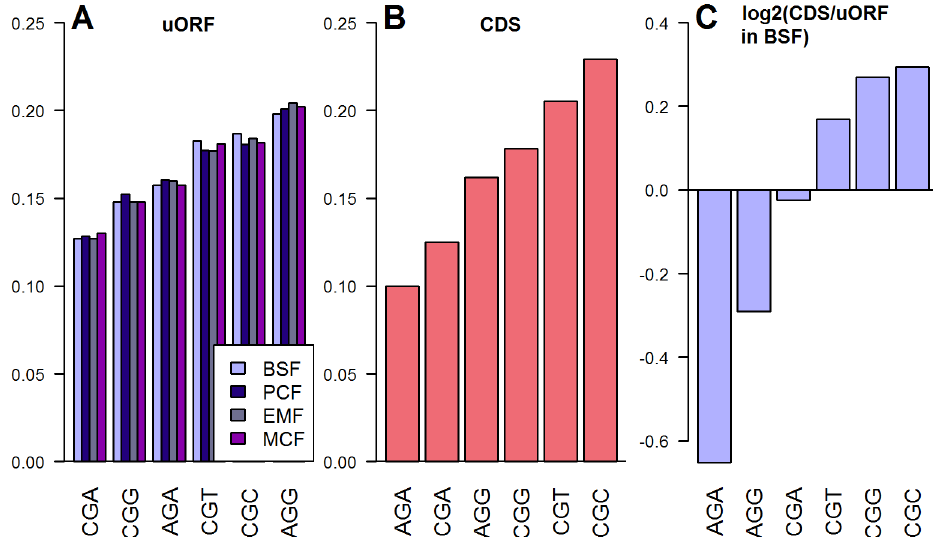
Fig 5. Codon usage bias in uORFs and CDSs on the example of arginine. For each amino acid, a subgroup of synonymous codons was composed (CGA, AGA, CGG, CGT, CGC and AGG for arginine). Subsequently, the normalized usage frequency of each codon was calculated. ( A ) Among the uORFs in all the four life cycle stages of T . congolense , AGG is the most frequently used codon for coding arginine and represents 20.0% of arginines. ( B ) Among the CDSs, the respective “preferred” codon is CGC, which accounts for 22.9% of arginines. ( C ) For a comparison of the normalized codon usage in CDSs and uORFs, BSF stage was used as an example. i.e. for coding arginine, CGC usage is 1.22 fold higher in CDSs, while AGA is employed 1.49 fold higher in uORFs.